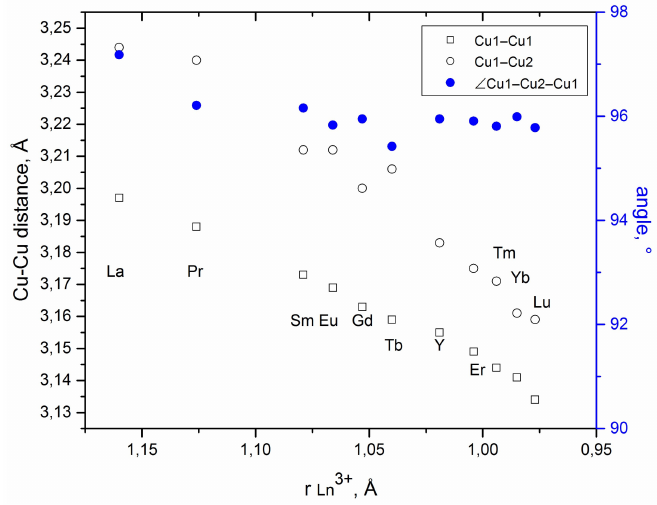
Figure 16. The variation of Cu1-Cu1, Cu1-Cu2, and ∠ Cu1-Cu2-Cu1 angles as function of ionic REM radii for Cu 3 Ln(SeO 3 ) 2 O 2 Cl